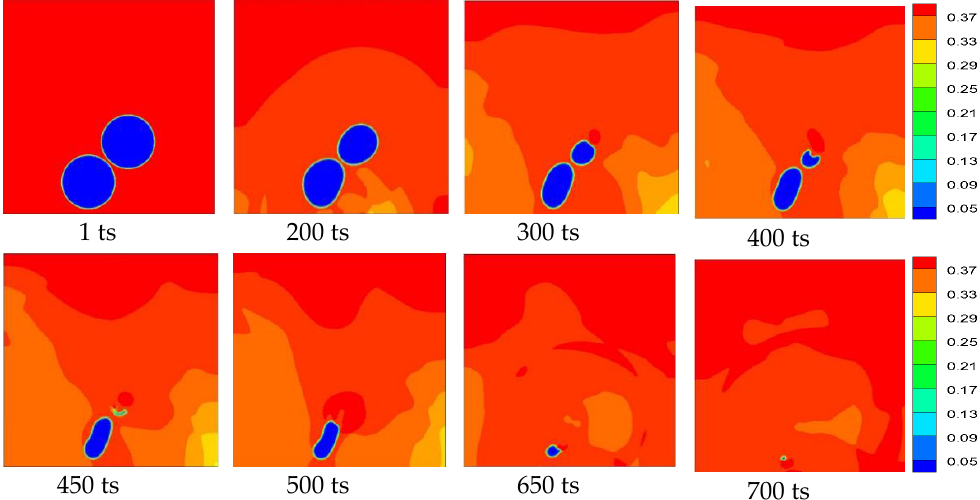
Figure 7. Density field of cavitation bubble collapse.